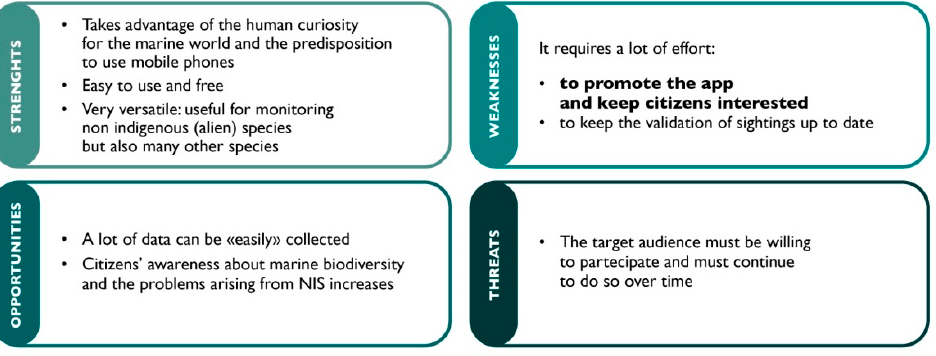
Figure 12. SWOT analysis of avvistAPP initiative.